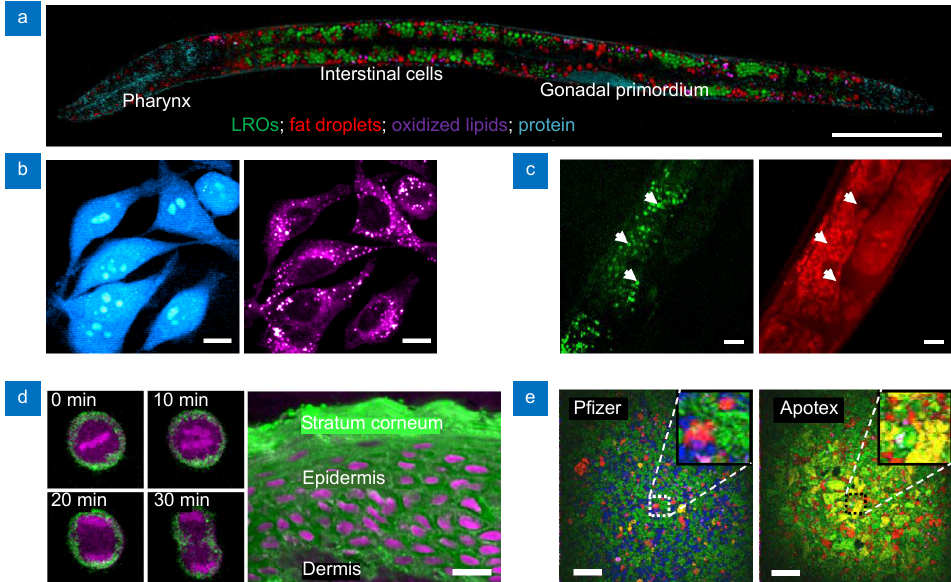
Fig. 8 | Stimulated Raman scattering imaging of biological samples. ( a ) Image of chemical mapping of C. elegans intracellular compartments, LROs: lysosome-related organelles, the scale bar is 50 mm. ( b ) Live HeLa cells, left: signals from C-D (2133 cm -1 ) showing deuterium-labeled amino acids, right: signals from C-H (2845 cm -1 ), the scale bars is 10 μ m. ( c ) Phenyl-diyne cholesterol in C. elegans, left: signal from C ≡ C (2247 cm -1 ) showing distinct cholesterol store, right: signal from C-H rich fat store (2885 cm -1 ), the scale bars is 10 mm. ( d ) Left: time-lapse of HeLa cell division, DNA (magenta), lipids (green); right: section of normal human skin tissue, DNA (magenta), lipids (green), the scale bar is 20 mm. ( e ) Drug tablets, green: microcrystalline cellulose, blue: dibasic calcium phosphate anhydrous, red: the drug amlodipine besylate, yellow/orange: sodium starch glycolate, magenta: magnesium stearate, the scale bars is 200 mm. Figure reproduced from ref. 203 , American Association for the Ad- vancement of